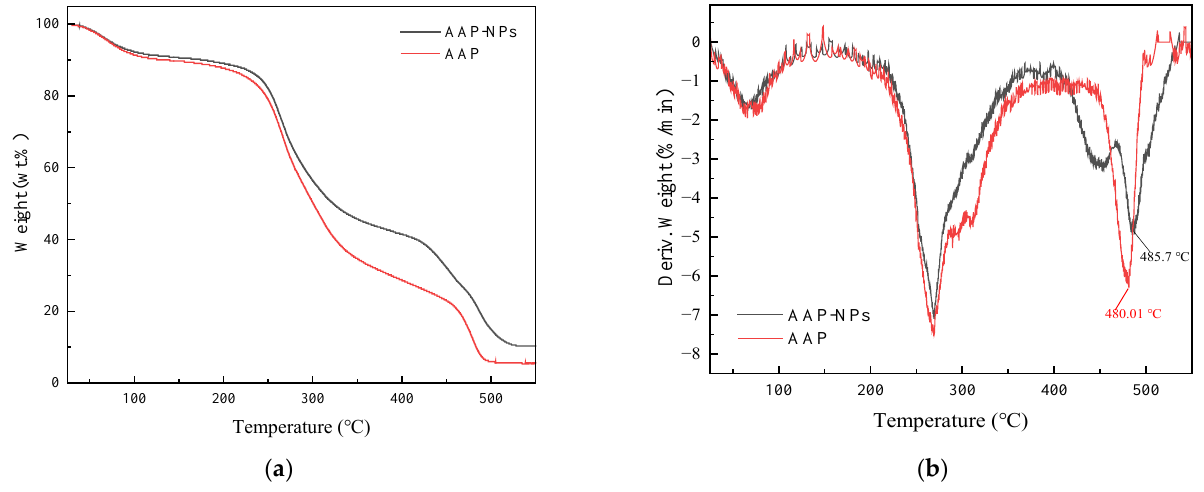
Figure 7. ( a ) Thermogravimetric (TG) and ( b ) derivative thermogravimetric (DTG) curves of AAP- NPs and AAP.